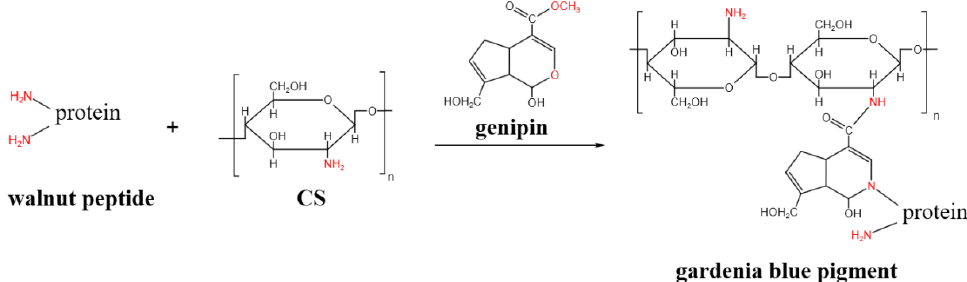
Figure 5. Proposed mechanism of genipin reaction with CS and walnut peptide to produce gardenia tif version blue